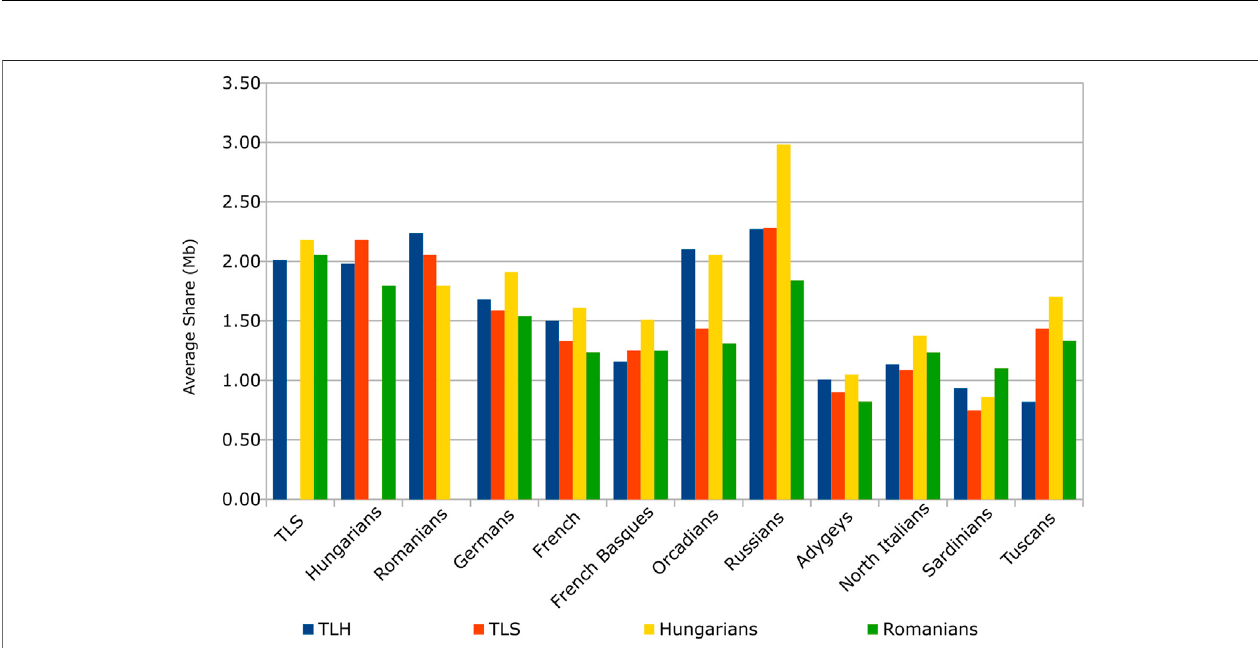
FIGURE 4 | Average pairwise IBD sharing between investigated